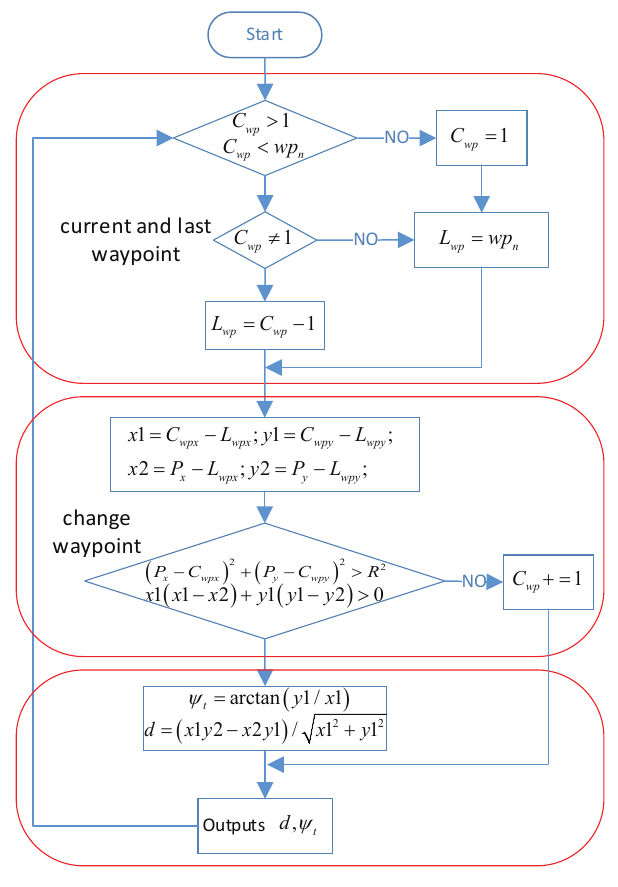
Figure 7. Switching logic of the